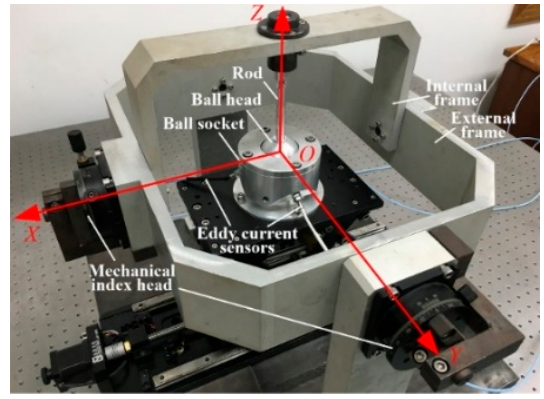
Figure 12. Mechanical biaxial angle platform.